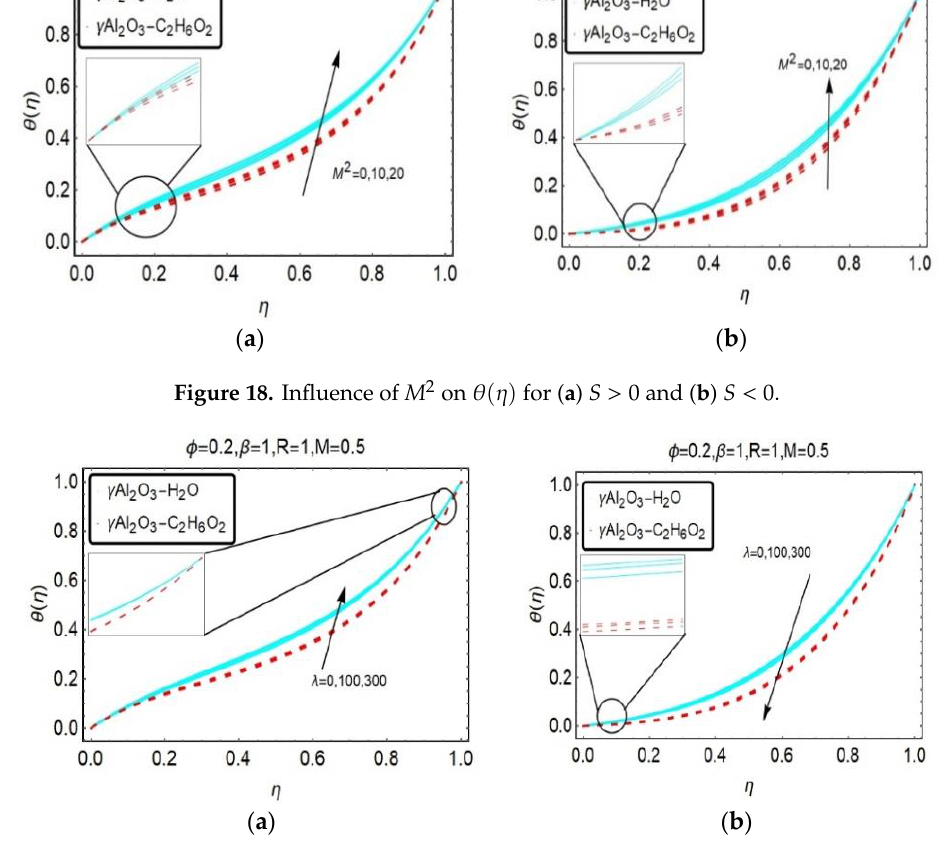
Figure 19. Influence of 𝜆 on 𝜃(𝜂) for ( a ) 𝑆 > 0 and ( b ) 𝑆 < 0.